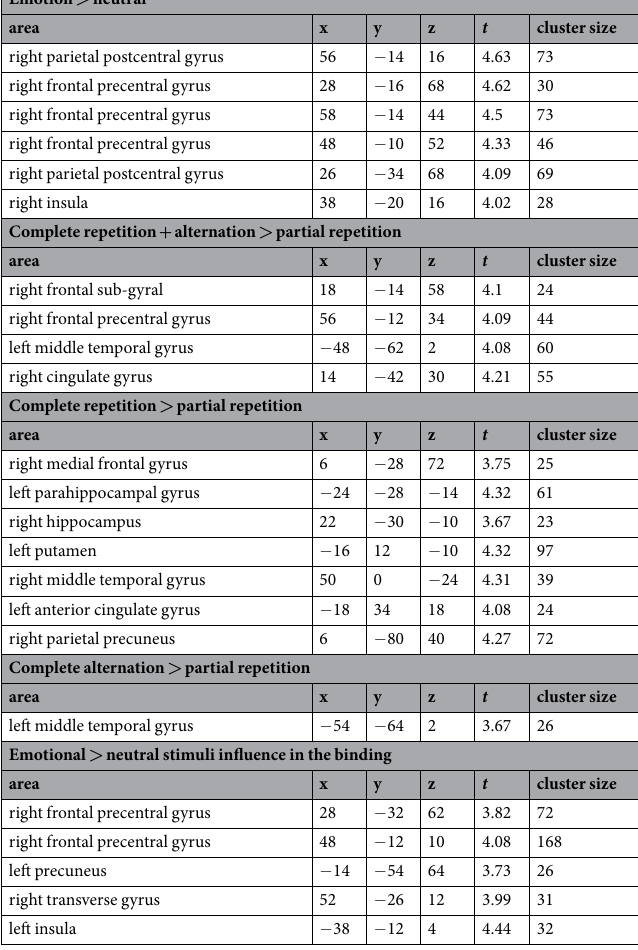
(vi) the right frontal precentral gyrus with the left parietal postcentral gyrus, the left middle temporal gyrus, and the right insula, (vii) the left putamen with the right hippocampus, (viii) the right middle temporal gyrus with the right cingulate gyrus, and (ix) the left middle temporal gyrus with the right frontal precentral gyrus and the left parietal postcentral gyrus.